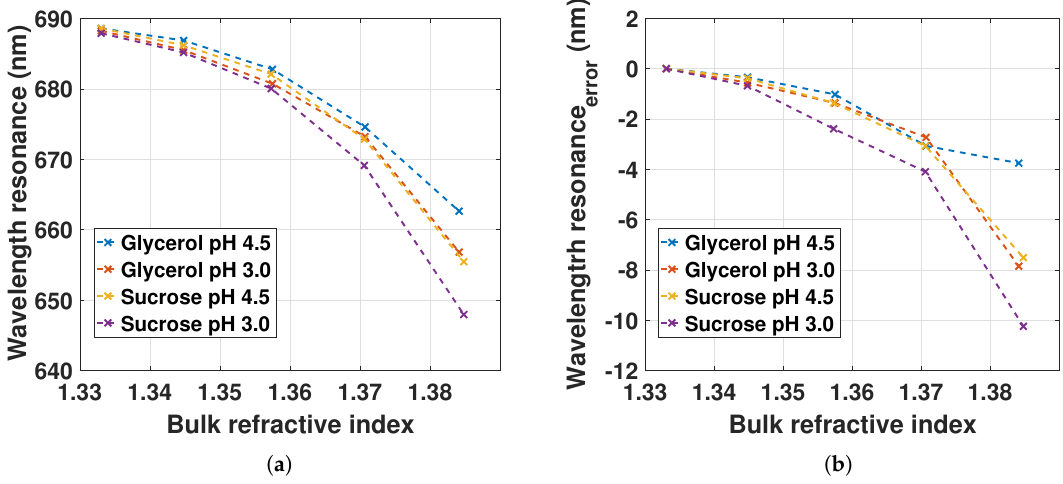
Figure 8. ( a ) LSPR peak position as a function of bulk RI with pH 4.5 and 3.0 for one sampled series; ( b ) the error of the LSPR peak position by holding the reference spectrum constant at R λ ( pH 4.5 ) for increasing bulk RI with pH 4.5 and